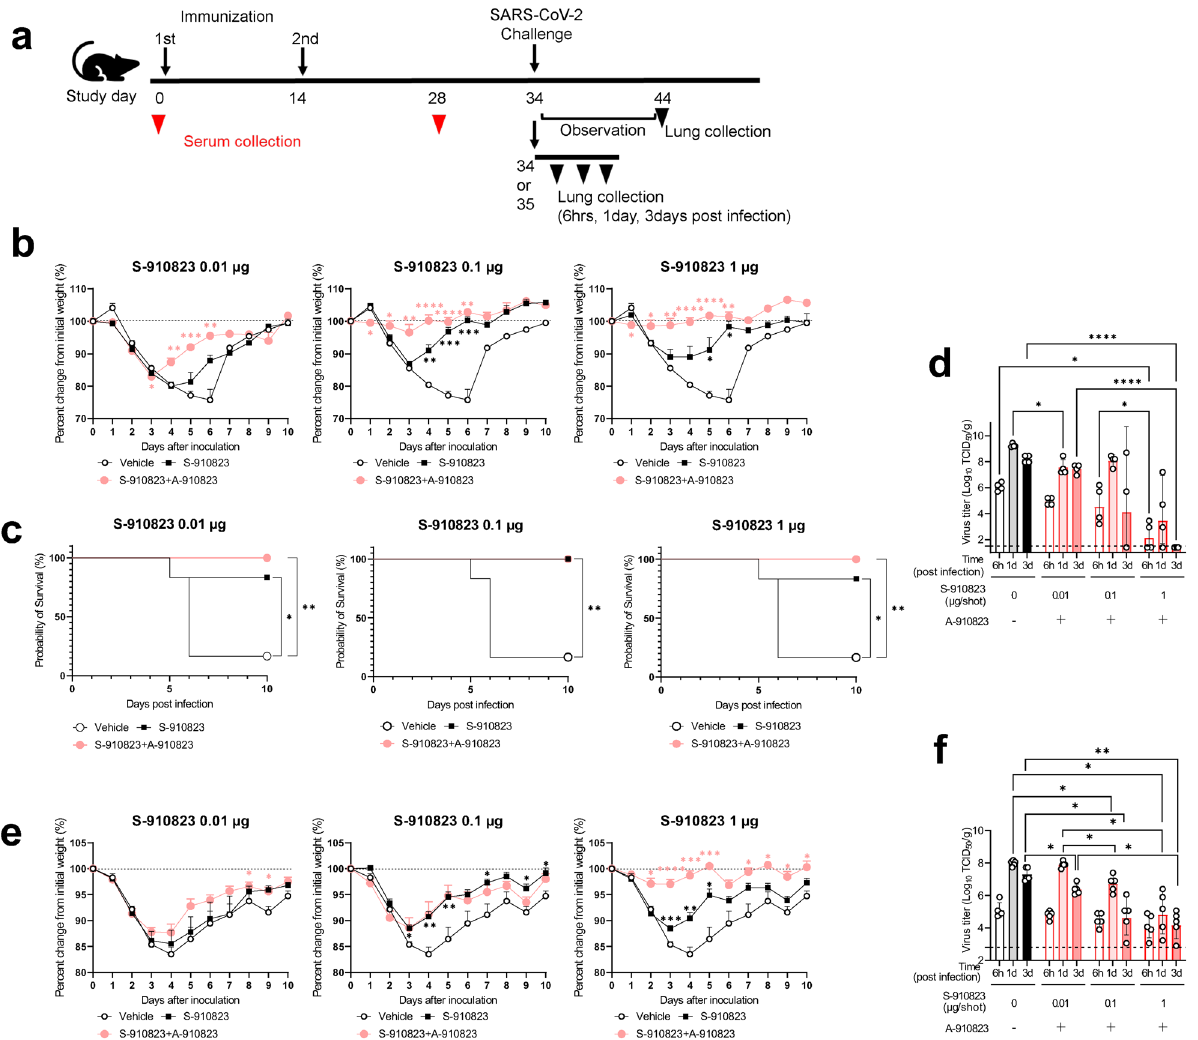
Figure 2. Protective efficacy of S-910823 plus A-910823 in a mouse infection model. ( a ) Study schedule schematic. On 20 d or 21 d post-second immunization, female mice were intranasally infected with severe acute respiratory syndrome coronavirus 2 (SARS-CoV-2). Bodyweight and mortality were monitored daily. The lungs were harvested at 6 h, 1 d, 3 d, and 9 d or 10 d post-infection. ( b ) and ( e ) Bodyweight changes in mice after infection with QHmusX (b, n = 6) or TY-8–612 (e, n = 8). Bodyweight of only surviving mice was measured. Each point represents the mean bodyweight of the particular group of mice (error bars indicate standard error of mean). Statistical significance was measured using Dunnett’s multiple comparison test (* P < 0.05, ** P < 0.01, *** P < 0.001, and **** P < 0.0001). ( c ) Survival curves of mice after infection with QHmusX. Statistical significance was measured using the log-rank test (* P < 0.05 and ** P < 0.005). ( d ) and ( f ) Infectious virus titers in mouse lungs at 6 h, 1 d, and 3 d post-infection with SARS-CoV-2 QHmusX (d, n = 4) and SARS-CoV-2 TY-8– 612 (f, n = 5). The titers are expressed as median tissue culture infective dose (TCID 50 )/g of tissue in VeroE6/ TMPRSS2 cells. The circles represent the titers in individual mice. The bars represent the geometric mean titers (error bars indicate standard deviation). The dotted lines represent the lower limit of detection. Statistical significance was determined using Tukey’s multiple comparison test (* P < 0.05, ** P < 0.01, and **** P <